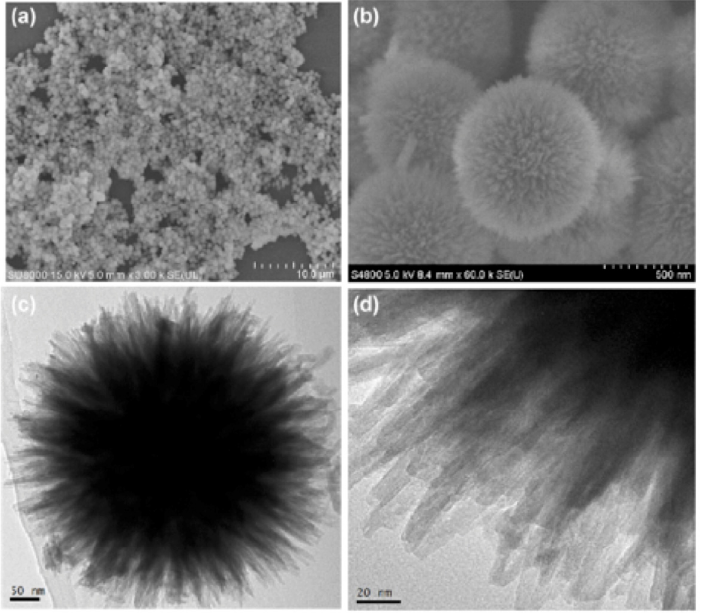
Figure 5. The SEM images ( a , b ) and TEM image ( c , d ) images of LaPO 4 -Citric acid-100 sample, reprinted with permission from [86].